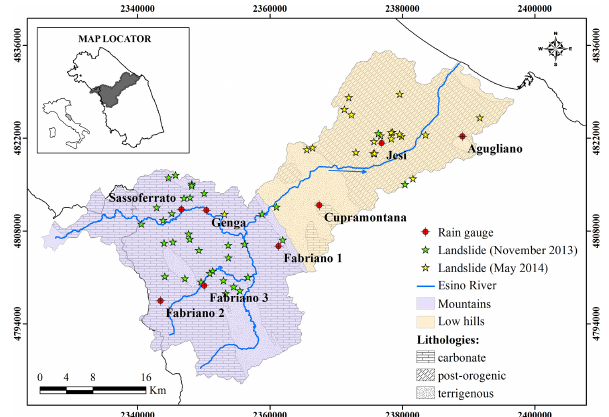
Figure 1. Study area: the Esino river basin, divided into mountain (purple) and low hill (light brown) areas. Map also shows the main lithologies of the study area, the names and the locations of the selected rain gauge stations, and the landslides triggered during the events of November 2013 and May